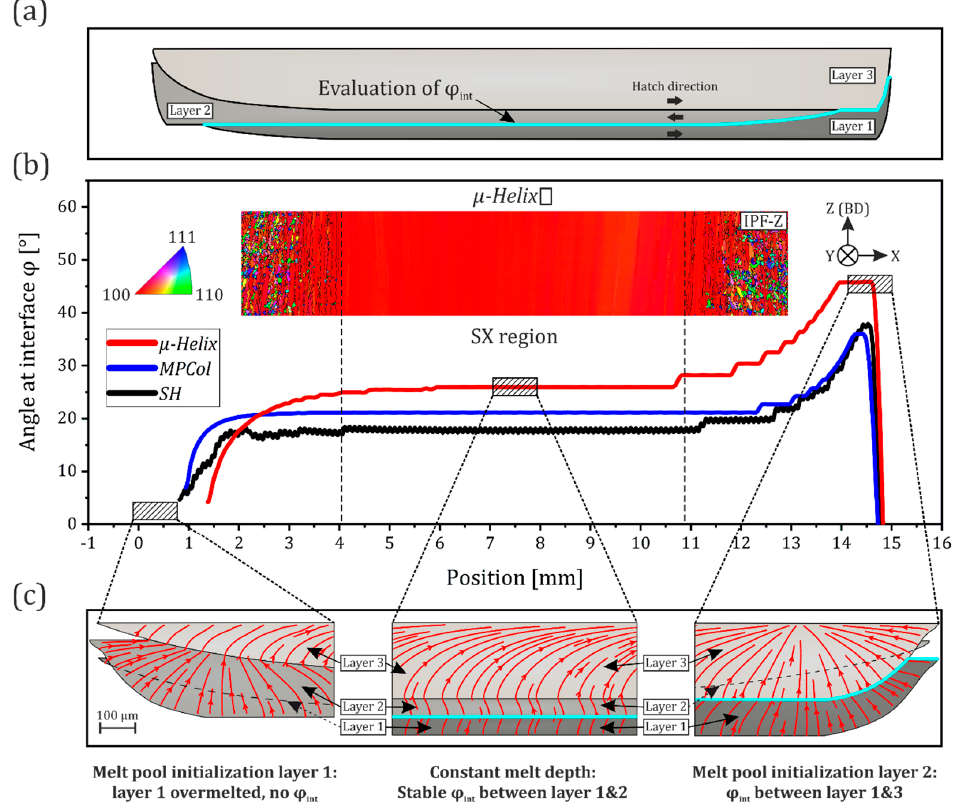
Figure 10. Analysis of the solidification conditions via S AM PLE 2D . ( a ) Schematic showing an overlay of three simulated layers. The resulting location for the evaluation of ϕ int is highlighted. ( b ) Deviation of the thermal gradient G from the BD at the interface between two layers ϕ int , as a function of the position within the simulation domain. The plotted curves resemble moving averages of the original data for enhanced visibility. A section of the EBSD IPF-Z map of the cuboid µ-Helix sample is fit in for comparison. ( c ) Detailed results of the simulation of µ-Helix. The red streamlines resemble the orientation of G, i.e., the solidification paths.